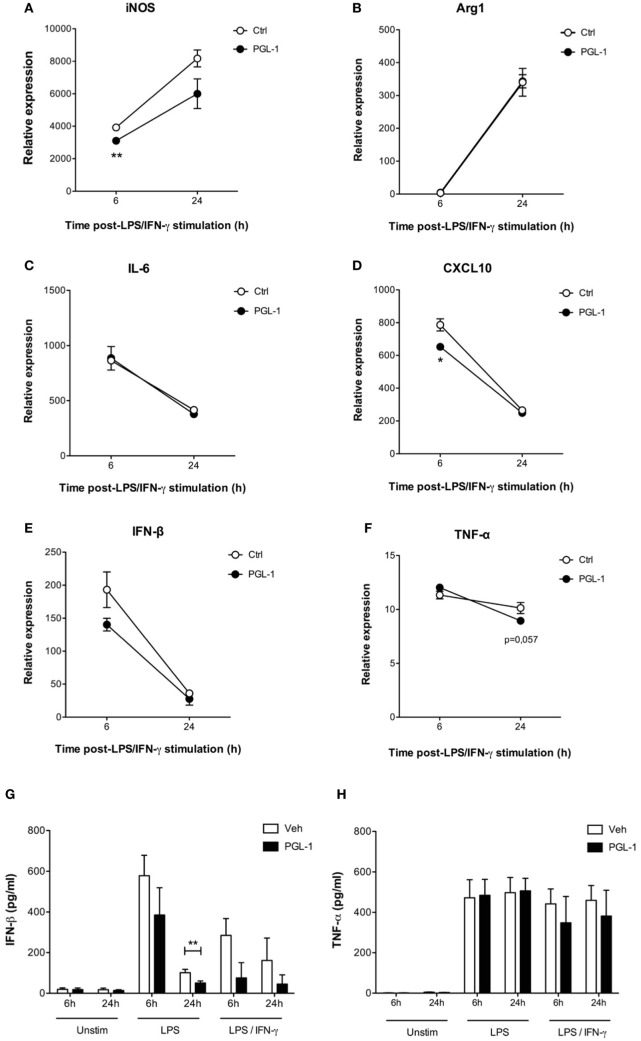
Phenolic glycolipid (PGL)-1-mediated decrease in TRIF impairs downstream signaling events. Quantitation of mRNAs in bone marrow-derived macrophages (BMDMs) treated with 25 µM PGL-1 or vehicle (Veh) for 24 h prior to 6–24 h of stimulation with LPS/IFN-γ: (A)
Nos2 (iNOS); (B)
Arg1 (Arginase 1); (C)
IL6 (IL-6); (D)
CXCL10 (CXCL10); (E)
Ifnb1 (IFN-β); (F)
Tnf (TNF-α). Data are relative mean transcript levels (n > 3) ± SEM. *P < 0.05, **P < 0.01, Student’s t-test, relative to RPL19 house-keeping gene. They are representative of at least two independent experiments with similar results. Production of IFN-β (G) and TNF-α (H) by BMDMs pretreated with 25 µM PGL-1 for 24 h prior to 6–24 h of stimulation with LPS (n = 6) or LPS/IFN-γ (n = 2). Data in (G,H) are mean cytokine concentrations from biological replicates ± SEM. **P < 0.01, Mann–Whitney test comparing PGL-1-treated cells to vehicle controls.